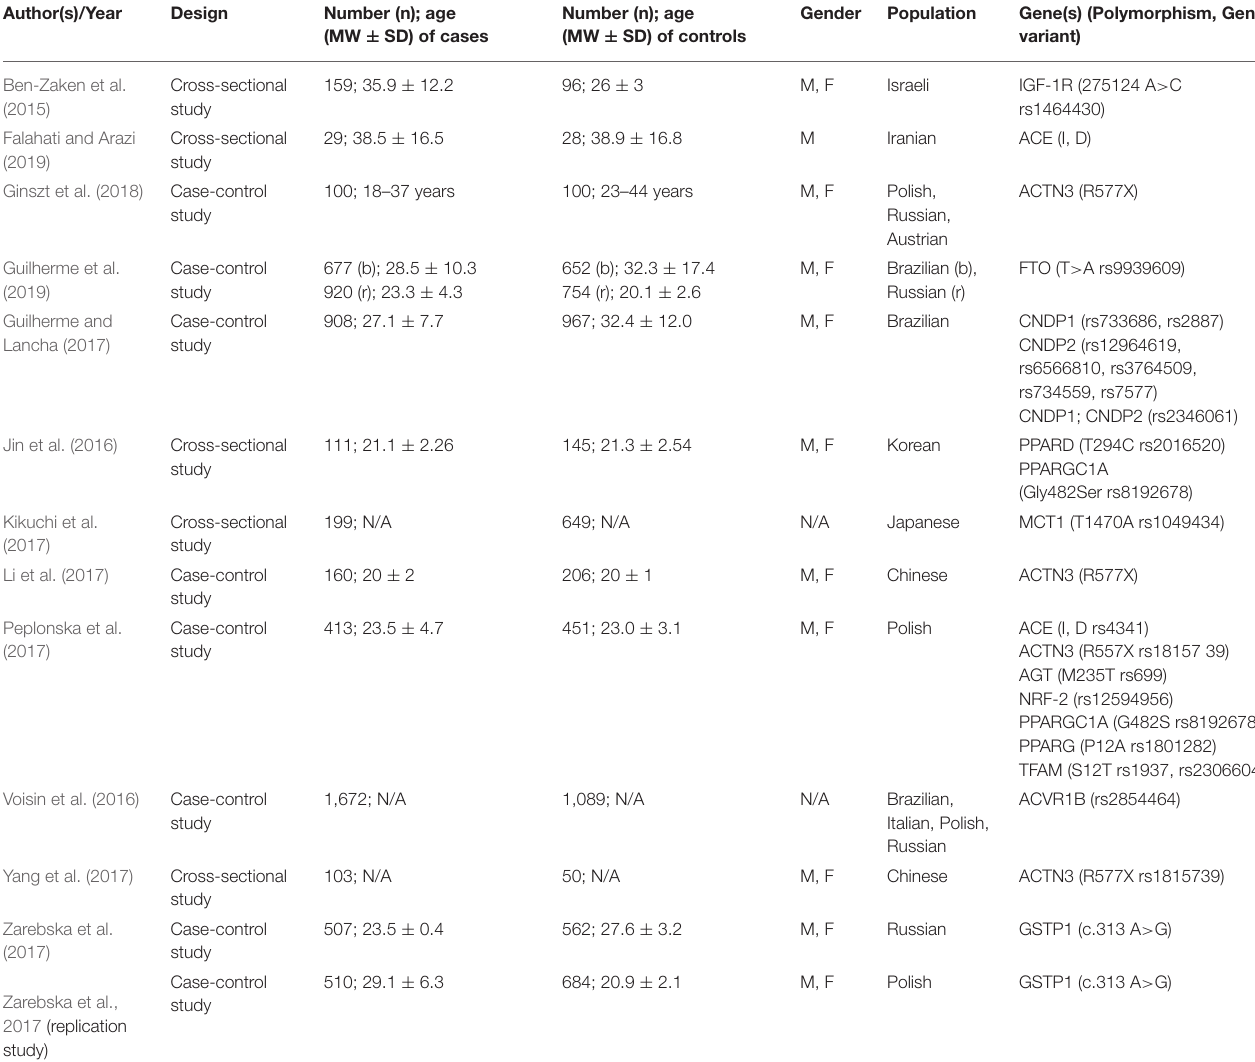
TABLE 3 | Characteristics of included studies on endurance and muscle